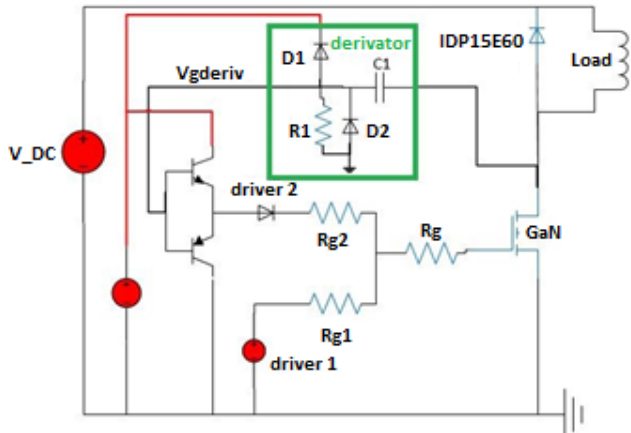
Figure 17. Schematic diagram of the proposed AGVC closed-loop during turn-off.